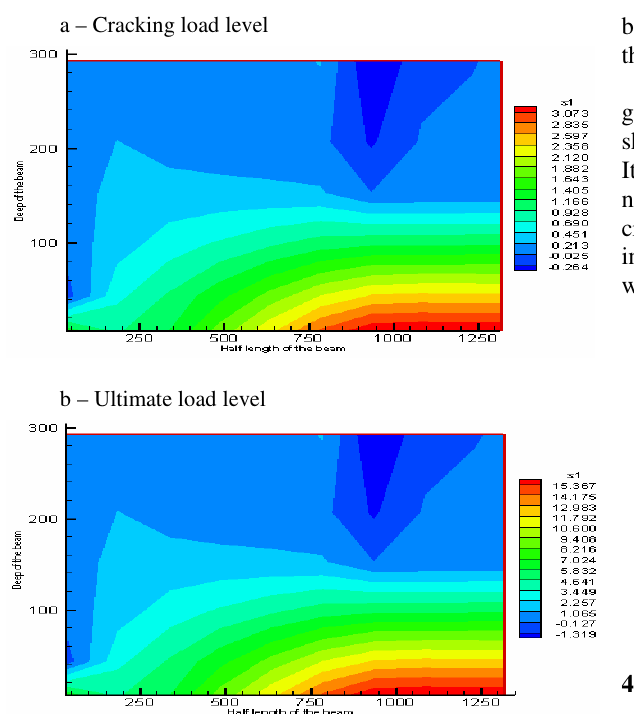
Fig. 11. Major principal stress distribution of bond slip model